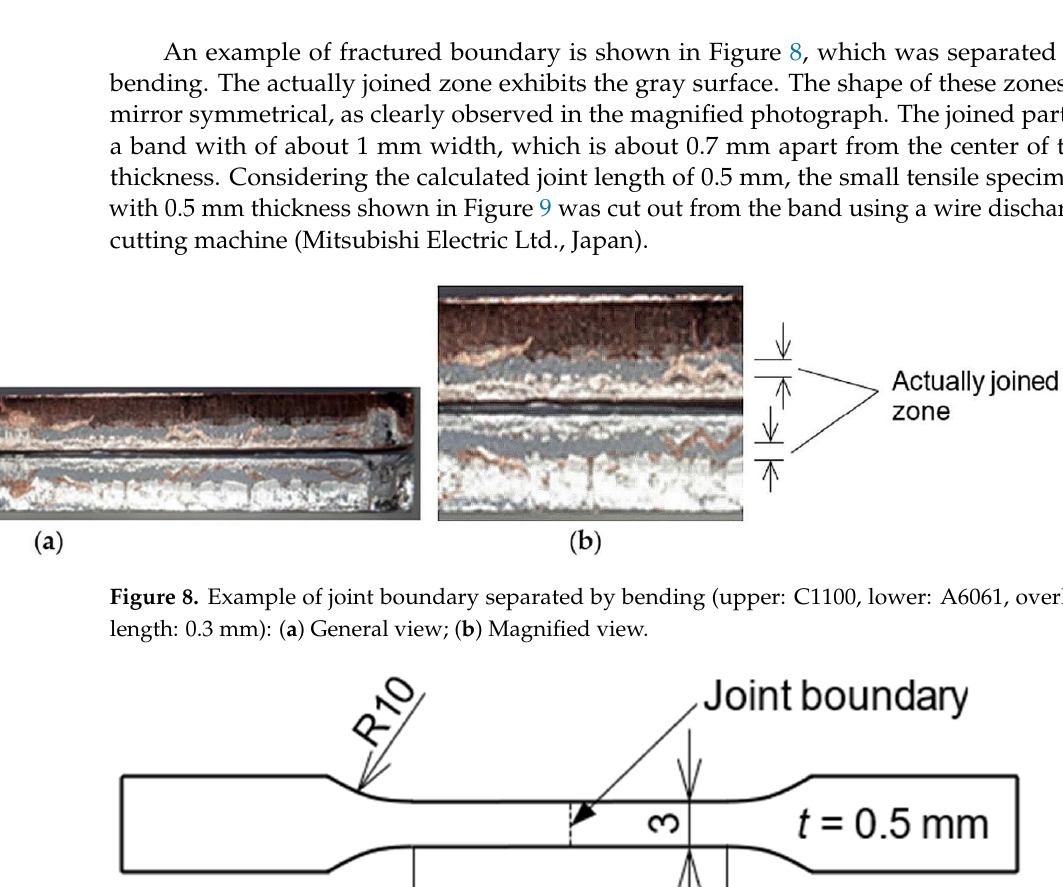
Figure 7. Fracture strength and joint efficiency in joining of C1100 and A6061 for various overlap lengths: ( a ) 0.1 mm; ( b ) 0.3 mm; ( c ) 0.5 mm; ( d ) 0.7 mm.